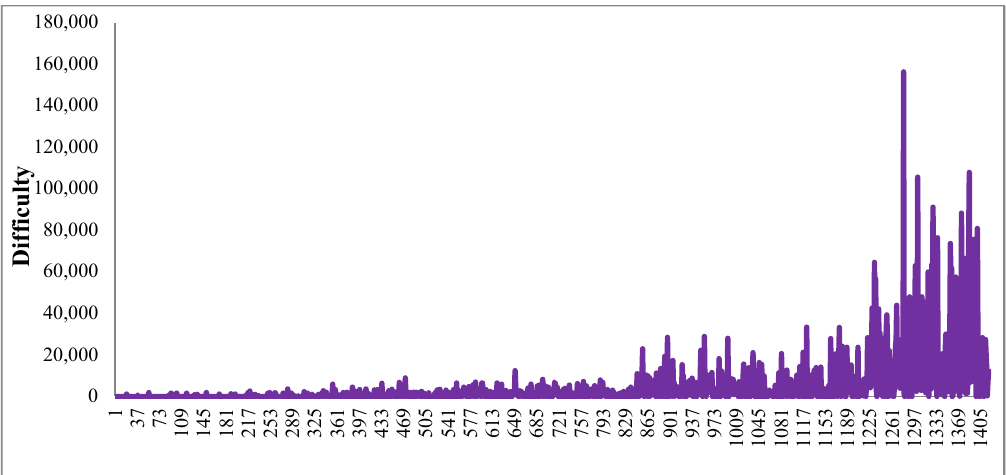
Figure 9. Displacement of required slot while weights set as [0,0,1] in test 3.